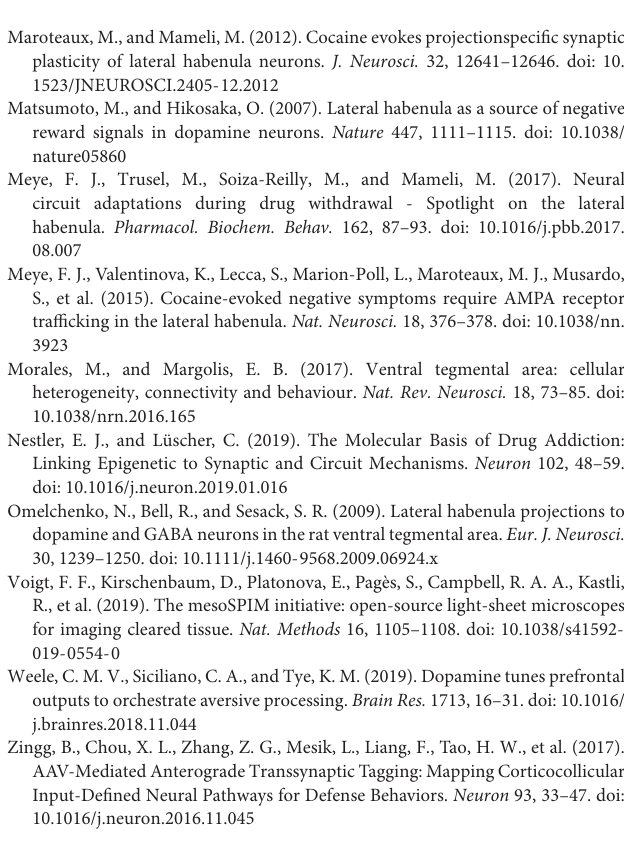
Supplementary Figure 1 | LHb terminal distribution in the RMTg. (A) Images (horizontal plane, Scale bar, 100 µ m, 10 × ) left to right: injection site in the LHb; mRuby positive axons in the RMTg; Synaptophysin-EGFP positive terminals in the RMTg. (B) Quantification in Relative Arbitrary Fluorescent (RAF) Units of